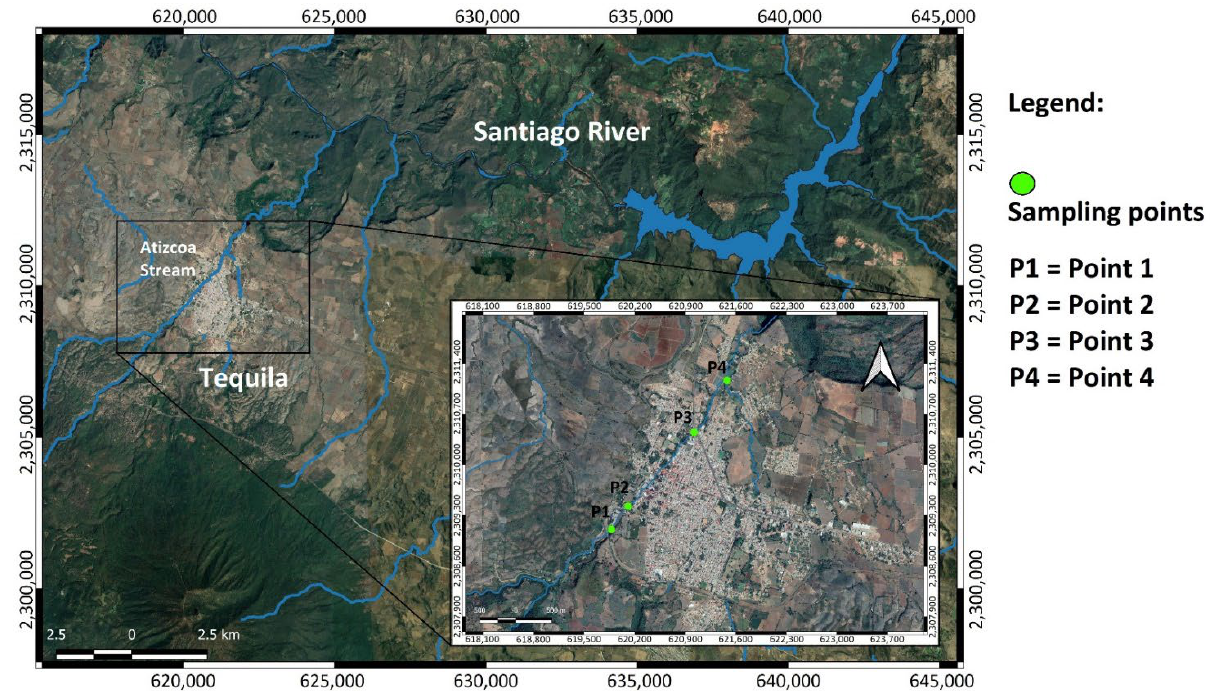
Figure 1. Sampling points along the Atizcoa stream.